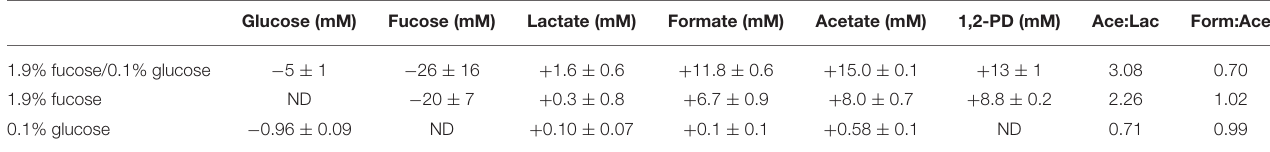
TABLE 1 | B. infantis extracellular metabolite production during growth in co-fermentation of fucose and glucose and on fucose and glucose as sole carbohydrate sources. Glucose (mM) Ace:Lac Form:Ace